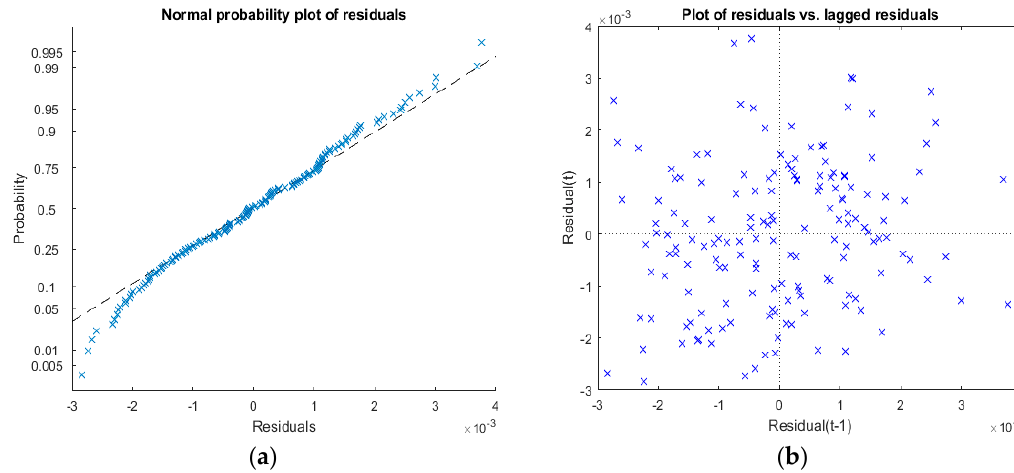
Figure 9. ( a ) Normal probability plot of the residuals of the fitted model; ( b ) Plot of residual vs. lagged residuals for serial correlation analysis.